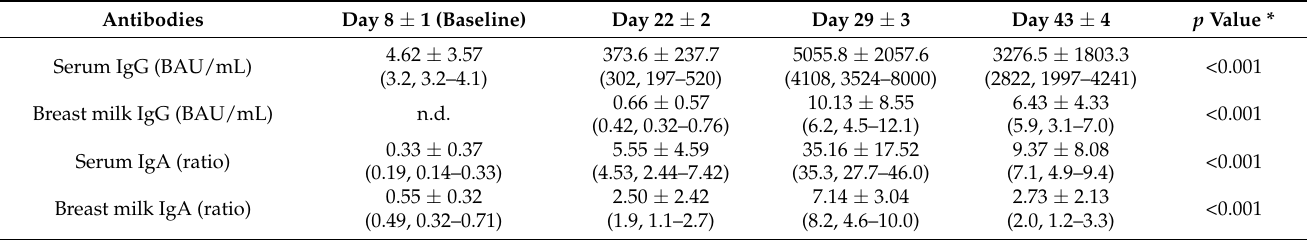
Table 3. Postvaccination serum and breast milk IgG and IgA